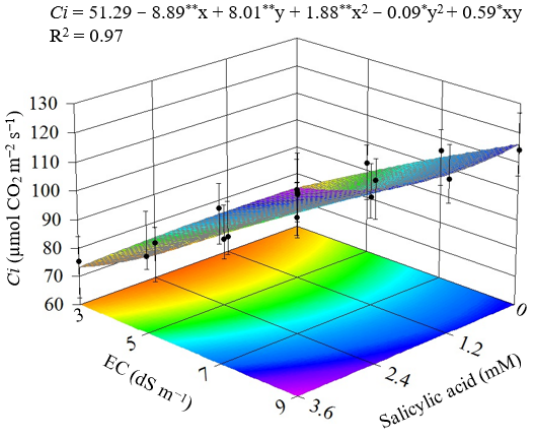
Figure 10. Response surface for internal CO 2 concentration— Ci of ‘Canindé’ okra cultivated in a hydroponic system as a function of the interaction between the electrical conductivity of the nutrient solution (EC) and the concentrations of salicylic acid 60 days after transplanting. X and Y—Concentration of salicylic acid and EC, respectively; * and ** significant at p ≤ 0.05 and ≤ 0.01, respectively. The vertical lines represent mean +/ − standard error (n =